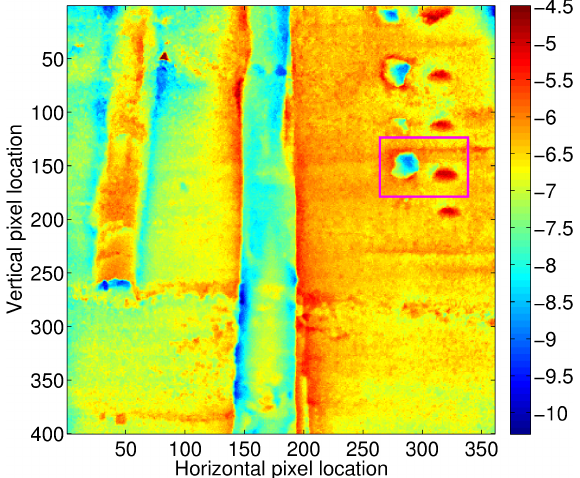
Fig. 5. Thermal image of the specimen shown in Fig. 1b after ap- proximately 4min in the cold lab. Artificial concavities are rela- Fig. 2. Thermal picture of a snow pit including a natural crust. Col- tively warm, convexities are relatively cold. The marked area is fur- orbar in ◦ C. ther analysed in Fig. 6. Colorbar in ◦ C.